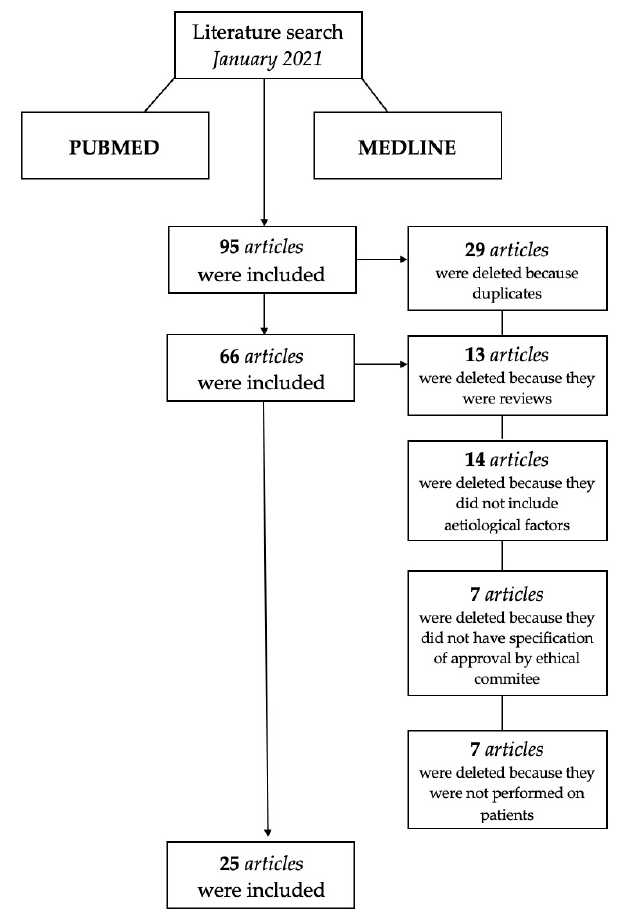
Figure 1. Flow chart of included studies.